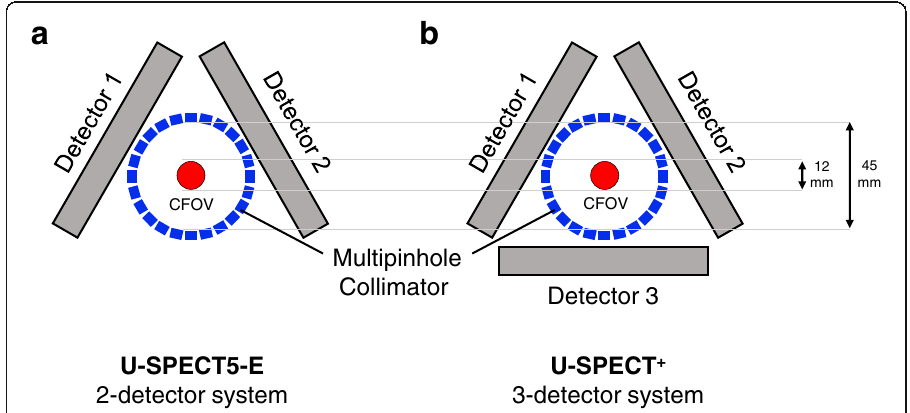
Fig. 1 Schematic cross section of the arrangement of the detectors of the new two-detector SPECT system (2DT-Scanner) ( a ) and a standard three-detector system (3DT-Scanner) ( b ). The surface of each stationary detector head, shown here as a square, has a size of 47.2 cm × 59.5 cm and consists of 9.5-mm-thick NaI(Tl) crystals. Collimators ’ inner diameter is 45.0 mm and centre field of view (CFOV) counts 12.0 mm diameter by 7.0 mm